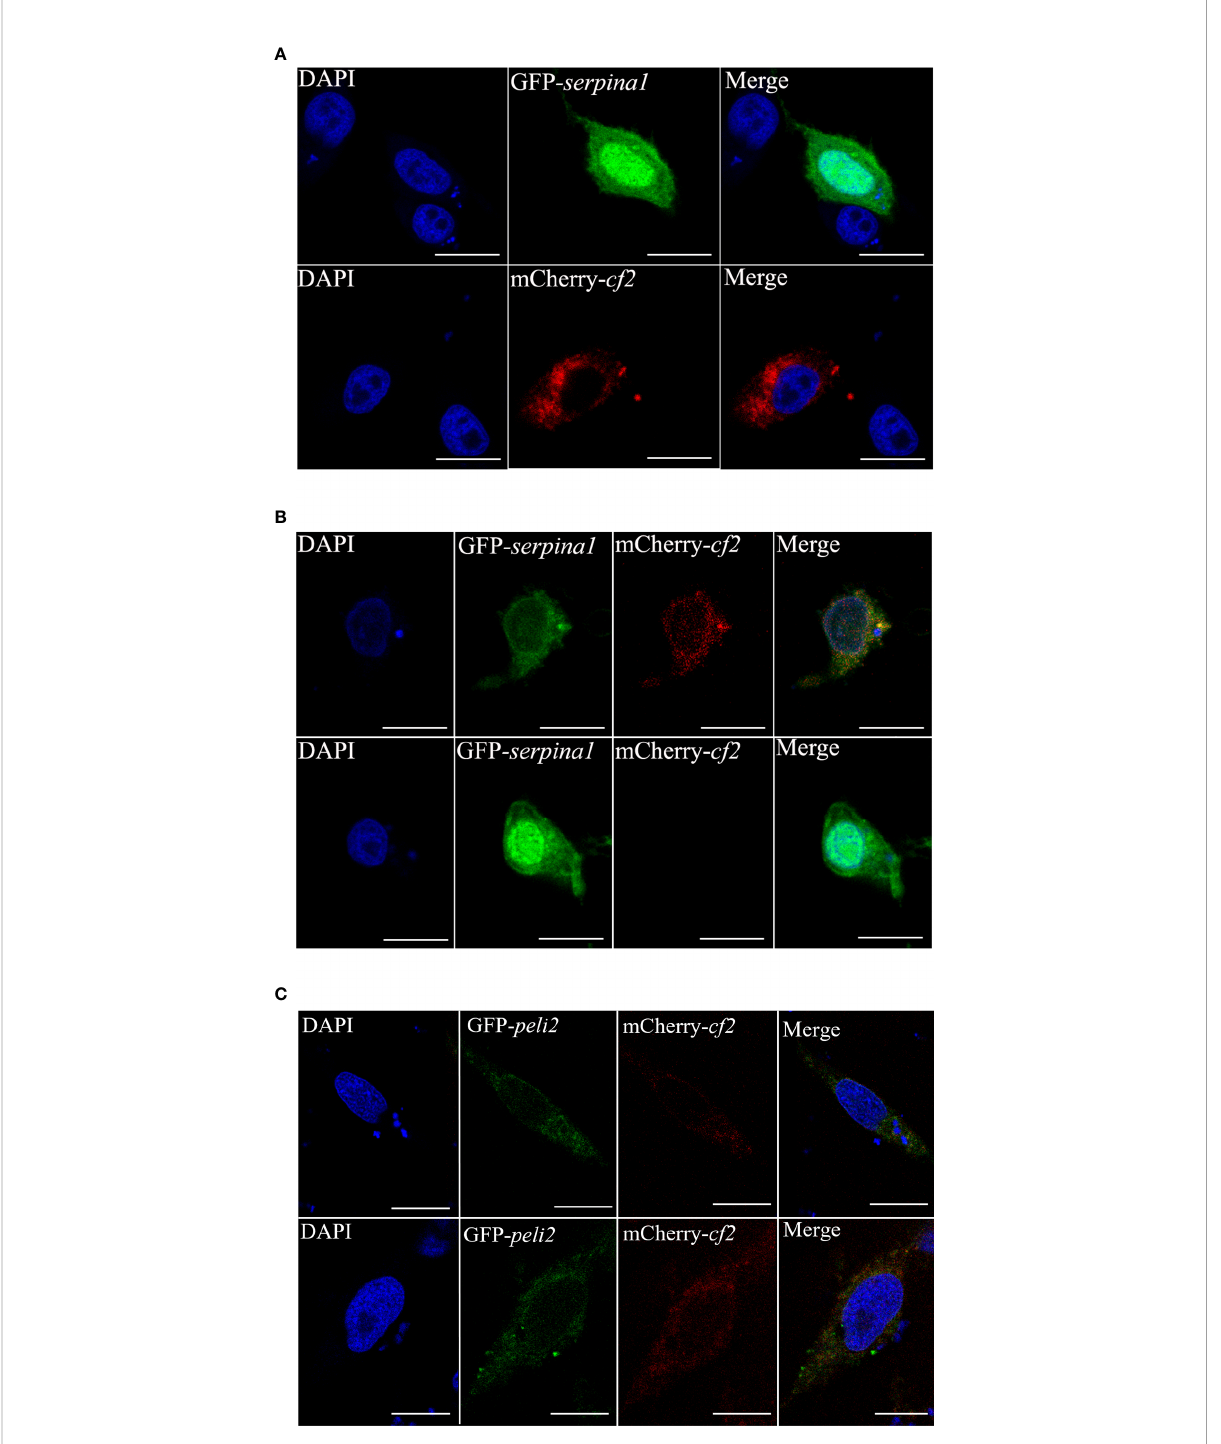
FIGURE 4 Subcellular co-localization of SERPINA1 and CF2 in CIK cells. (A) CIK cells expressing CF2 (top) or SERPINA1 (bottom) alone under confocal microscopy observation. The green fl uorescent signal indicates SERPINA1 protein, the red fl uorescent signal indicates CF2 protein, and the blue fl uorescence indicates nucleus. (B) Fluorescence observation of CIK cells after co-expression of SERPINA1 and CF2 for 24 h (top) and 48 h (bottom). (C) Fluorescence observation of CIK cells after co-expression of PELI2 (GFP-tagged irrelevant protein) and CF2 for 24 h (top) and 48 h (bottom). The scale bar is 10 m